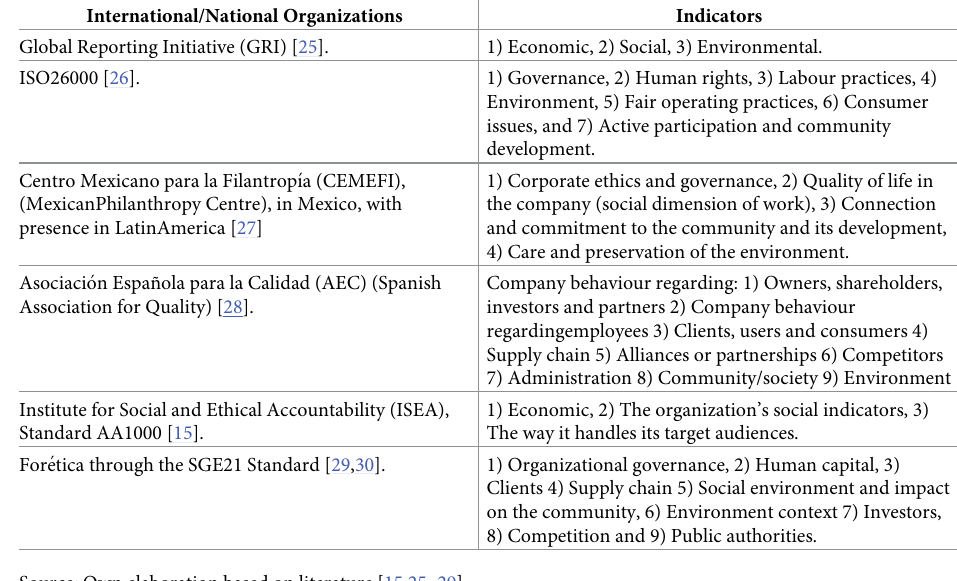
Table 1. CSR model indicators: GRI, ISO26000, CEMEFI, AEC, AA1000, SGE21. International/National Organizations Indicators Global Reporting Initiative (GRI) [25]. 1) Economic, 2) Social, 3) Environmental. ISO26000